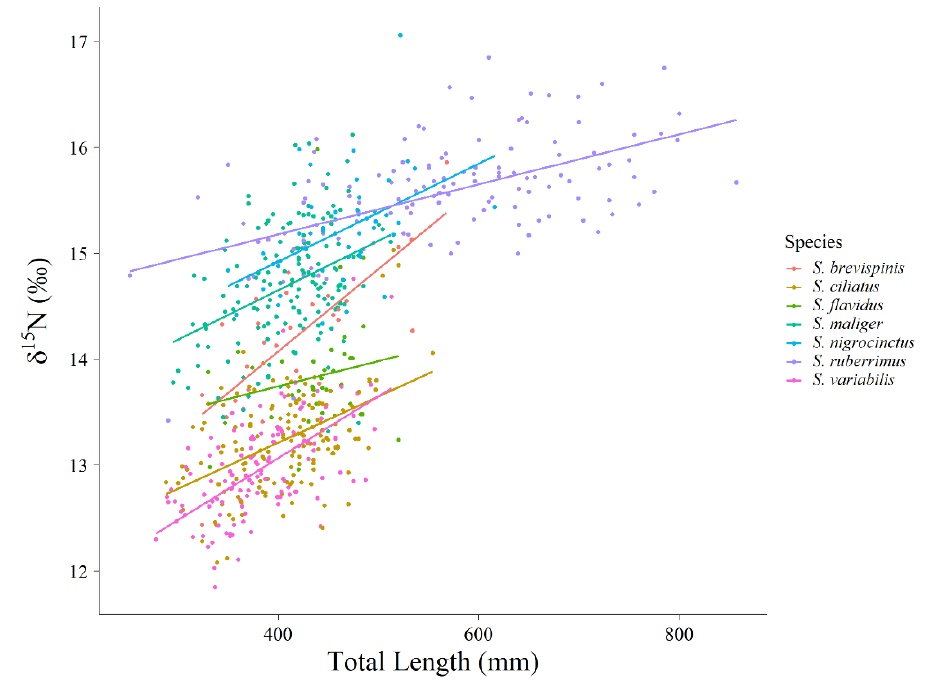
Figure 9. Ontogenetic shifts in δ 15 N by total length for seven rockfish species in this assemblage.